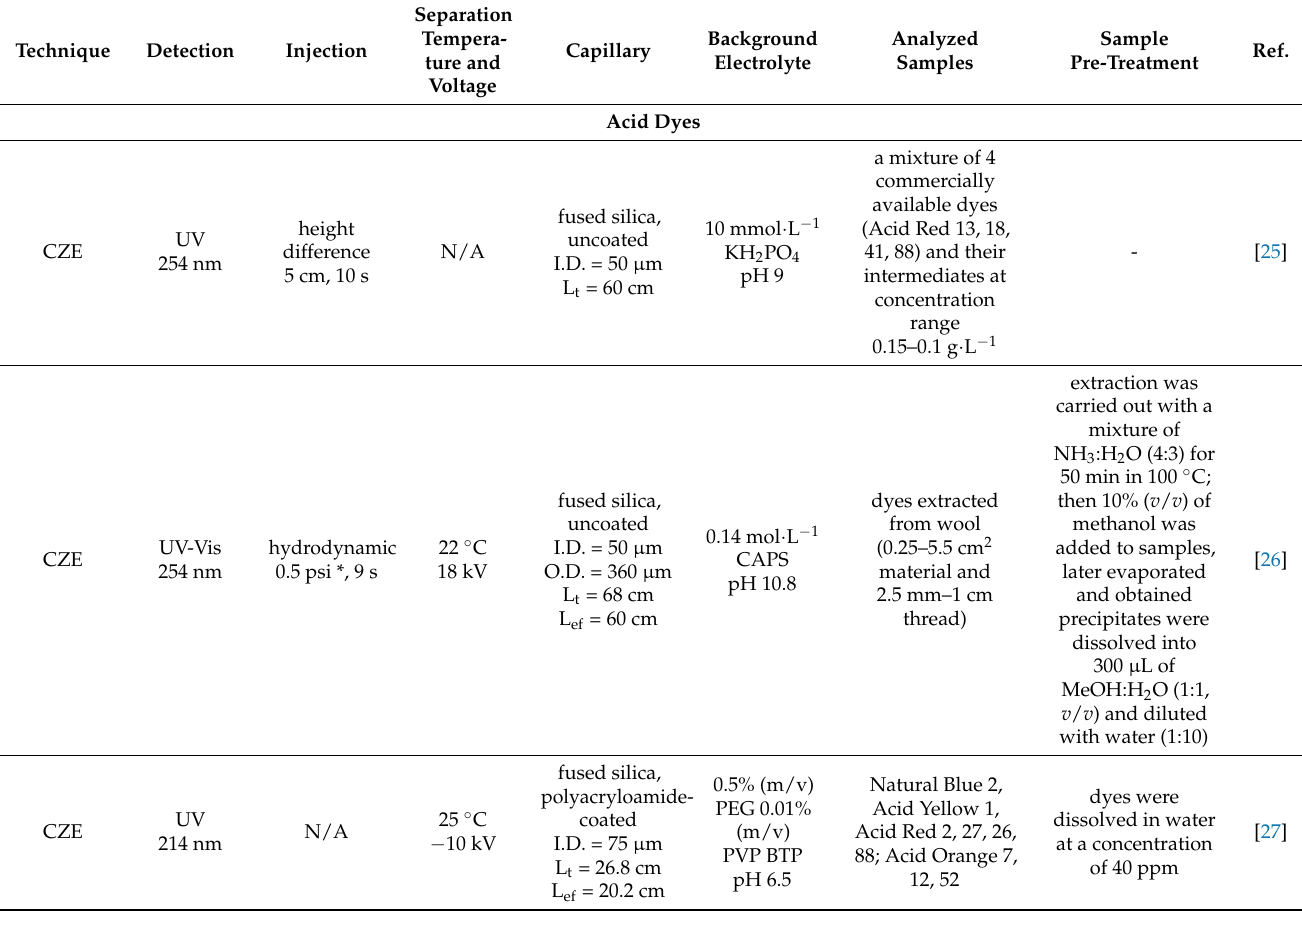
Table 2. Condition of detection, injection, separation as well as the composition of background electrolyte (BGE) used in the CEMs dedicated for analysis of textile